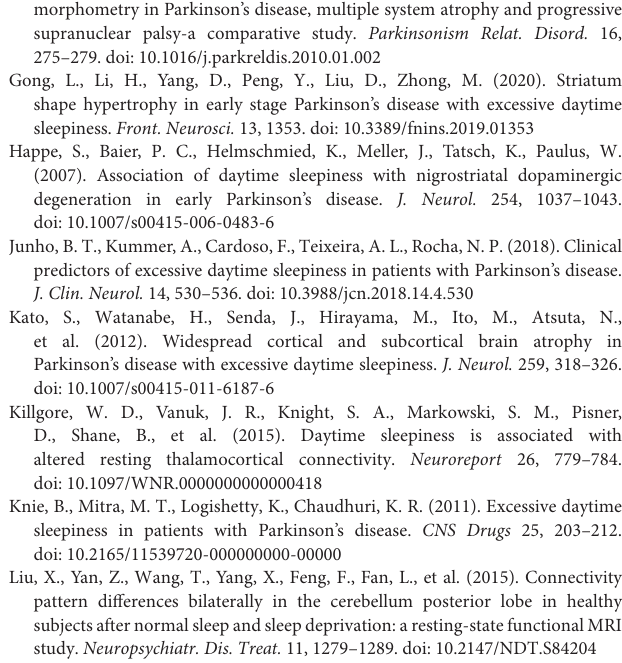
FIGURE 3 | the right anterior cerebellar lobe/right brainstem, right middle temporal gyrus and inferior temporal gyrus, right hippocampus/para hippocampus, right medial and lateral cingulate gyrus, bilateral occipital middle gyrus was decreased in PD-EDS patientscompared with the PD-NEDS patients (blue area in the figure) ( P < 0.05, after AlphaSim correction). (C) Taking the left thalamus as the seed point, the FC in the bilateral superior temporal gyrus, the left insula, and the right precuneus were increased in PD-EDS patients compared with the PD-NEDS patients (red area in the figure) ( p < 0.05, After AlphaSim